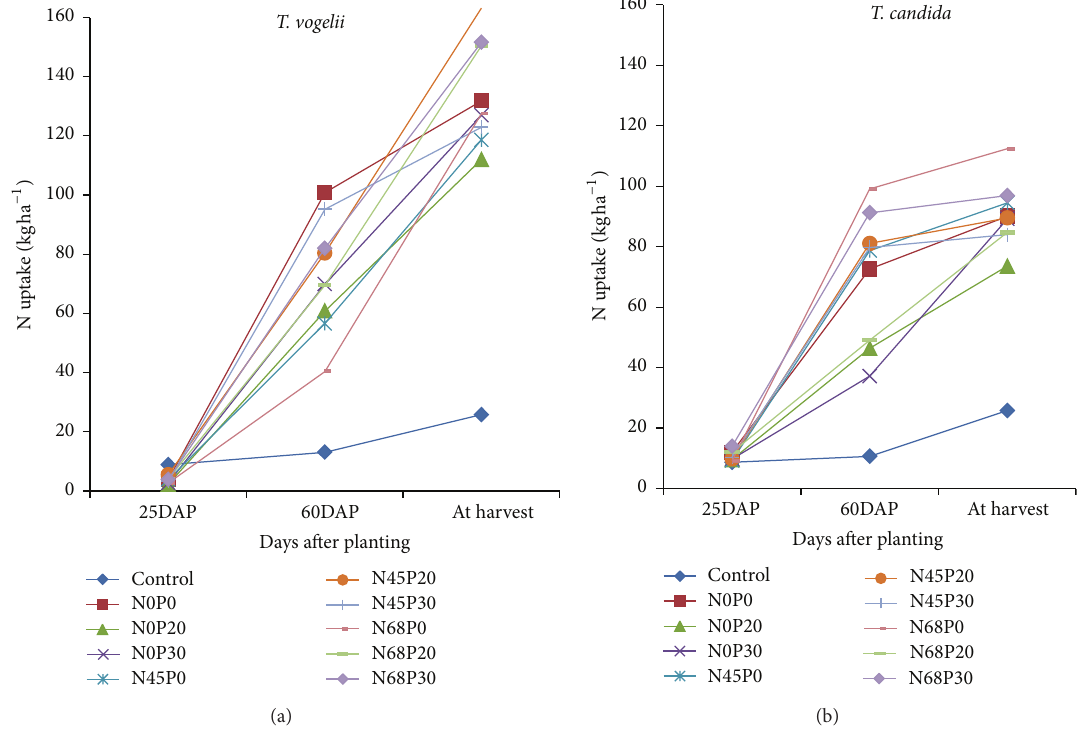
Figure 1: Effect of T. vogelii and T. candida biomass and inorganic fertilizers on maize N